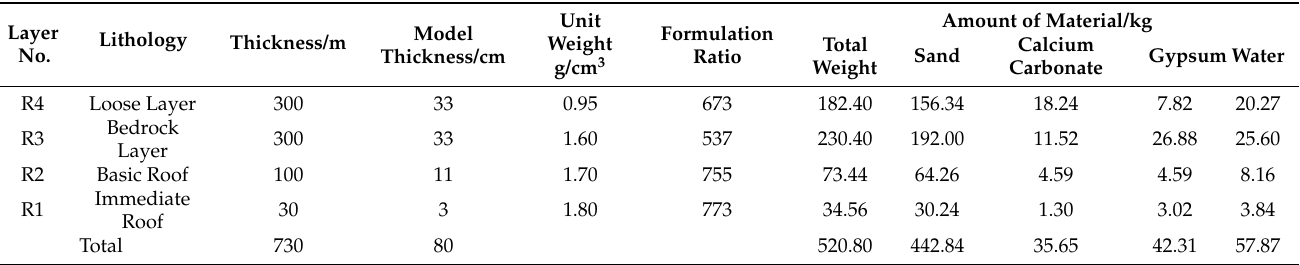
Table 1. Formulation ratio of the